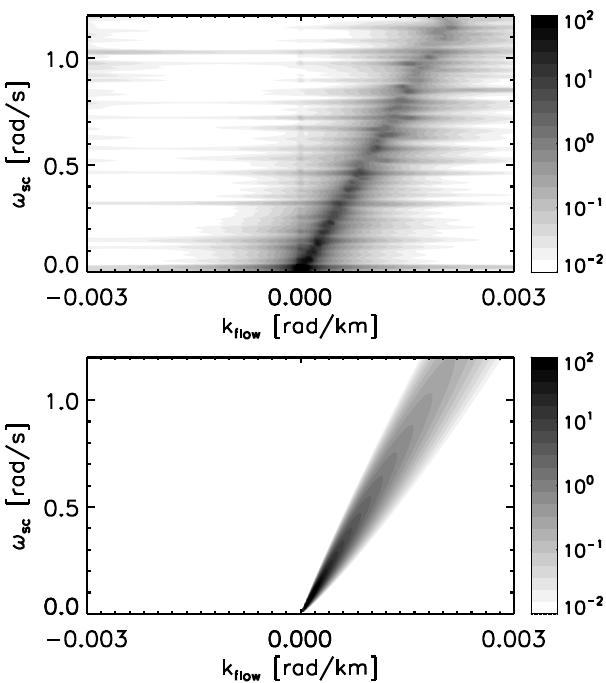
Fig. 3. Slice of the energy spectrum in the plane spanned by spacecraft-frame frequencies and streamwise wavenumbers derived by four Cluster spacecraft data (upper panel) and the reconstructed energy spectrum using the method of model fitting (lower panel). Best fitting was obtained for the parameter set U = 547 . 6km (Doppler shift) and V = 49 . 6km (Doppler broadening).